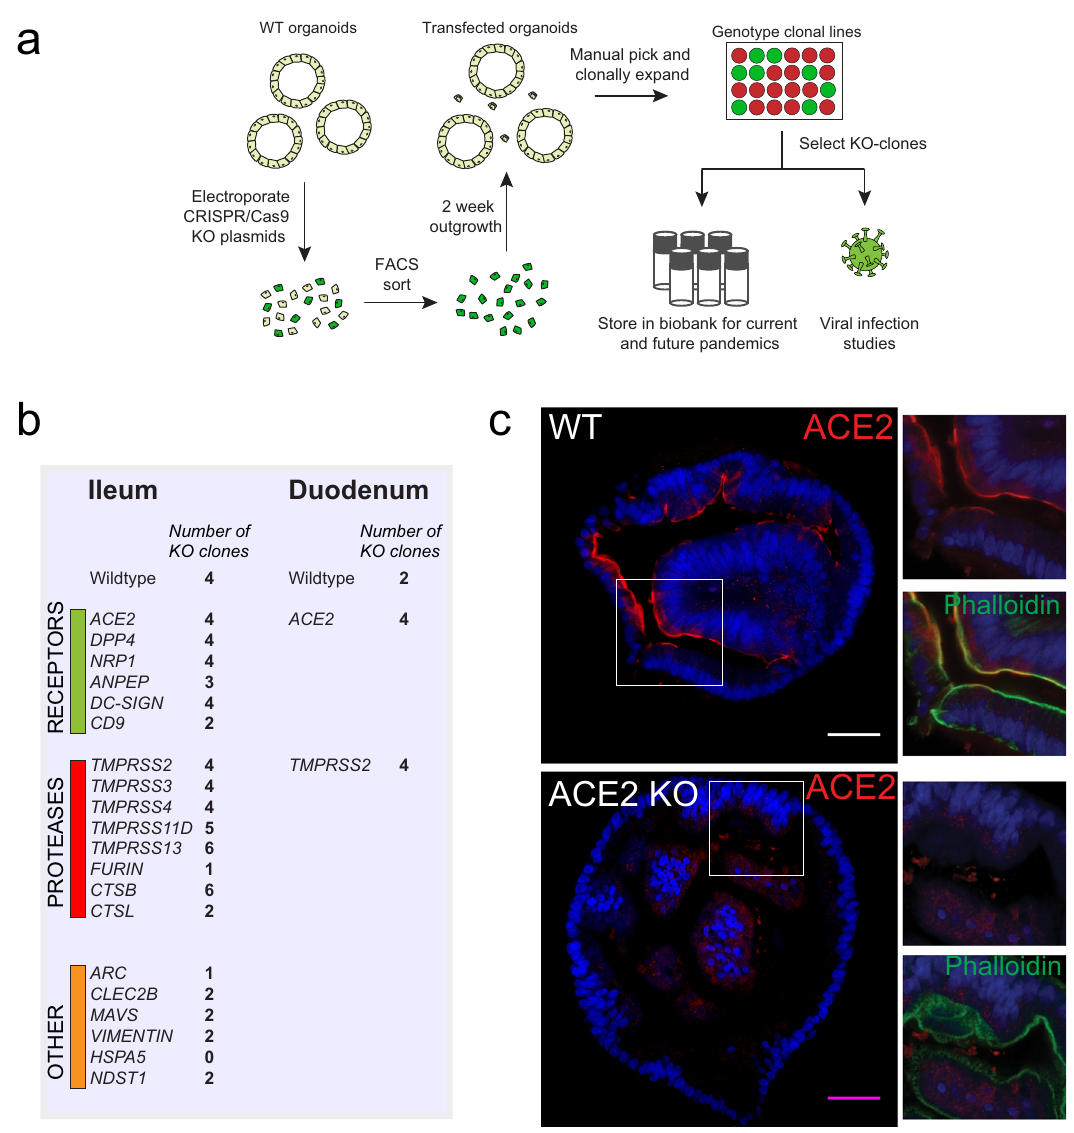
Fig. 2 Generation of a coronavirus host gene knockout biobank. a Overview of the work fl ow of generation of gene knockouts. b Overview of the number of clones that were ampli fi ed and biobanked in this study. c Immuno fl uorescent staining of WT and ACE2 KO organoids. ACE2 locates to the apical membrane and is absent in mutant organoids. Scale bars are 50 µ m. Contrast was enhanced in unzoomed images for visualization purposes. Experiment was repeated 3 times with similar